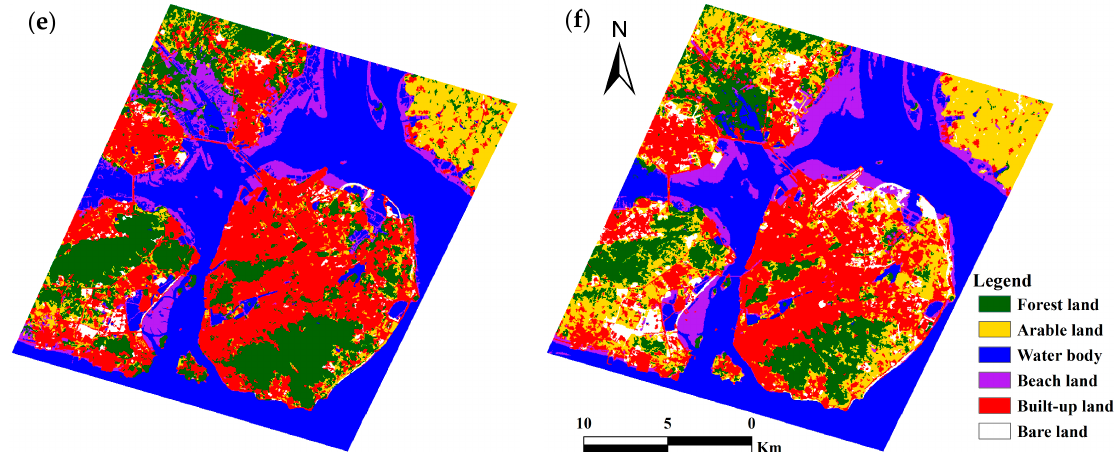
Figure 9. LULC classification results. ( a ) Feature-based approach of decision tree classification (FBA-DTC) applied to the image from 2015; ( b ) MLC applied to the image from 2015; ( c ) FBA-DTC applied to the image from 2007; ( d ) MLC applied to the image from 2007; ( e ) FBA-DTC applied to the image from 2003; ( f ) MLC applied to the image from 2003.